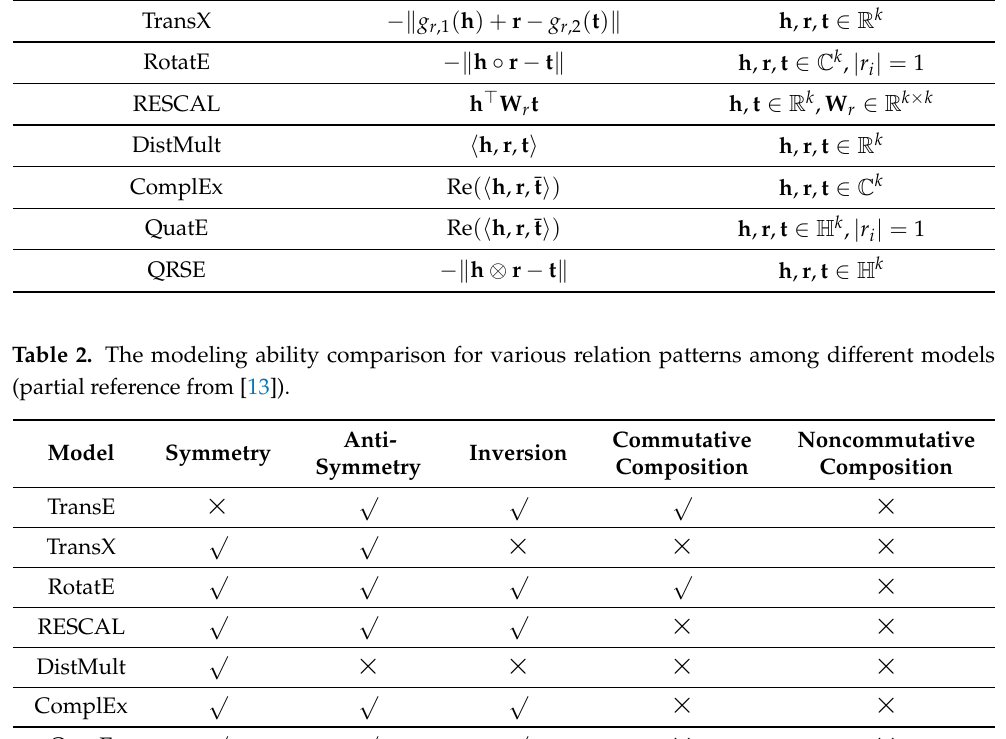
. = ∑ k a i b i c i i = 1